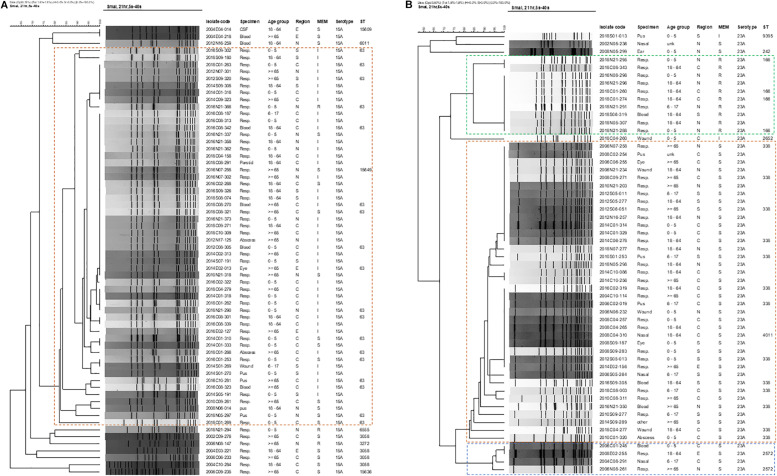
Dendrograms of pneumococcal isolates of emerging meropenem-non-susceptible (A) serotype 15A, and (B) serotype 23A based on SmaI-digested PFGE patterns. Isolate code, the first 4 digits indicate isolation year, followed by region [C (central), N (northern), E (eastern), S (southern)] and 2 digits of hospital number, then 3 digits of isolate number. Other abbreviations: MEM, meropenem; S, susceptible; I: intermediate; R, resistant; ST, sequence type.